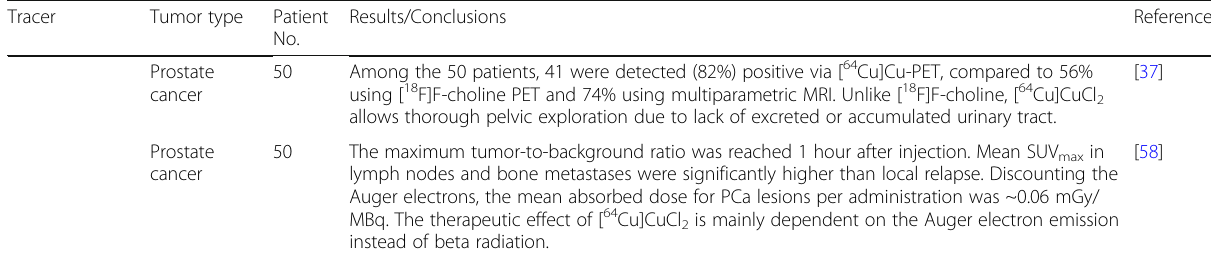
Table 1 Clinical studies using *copper(II)-diacetyl-bis(N4-methylthiosemicarbazone) ([ * Cu][Cu(ATSM)]) or *Cu-dichloride ([ * Cu]CuCl 2 ) as radioactive tracer in PET (Continued) Tracer Patient